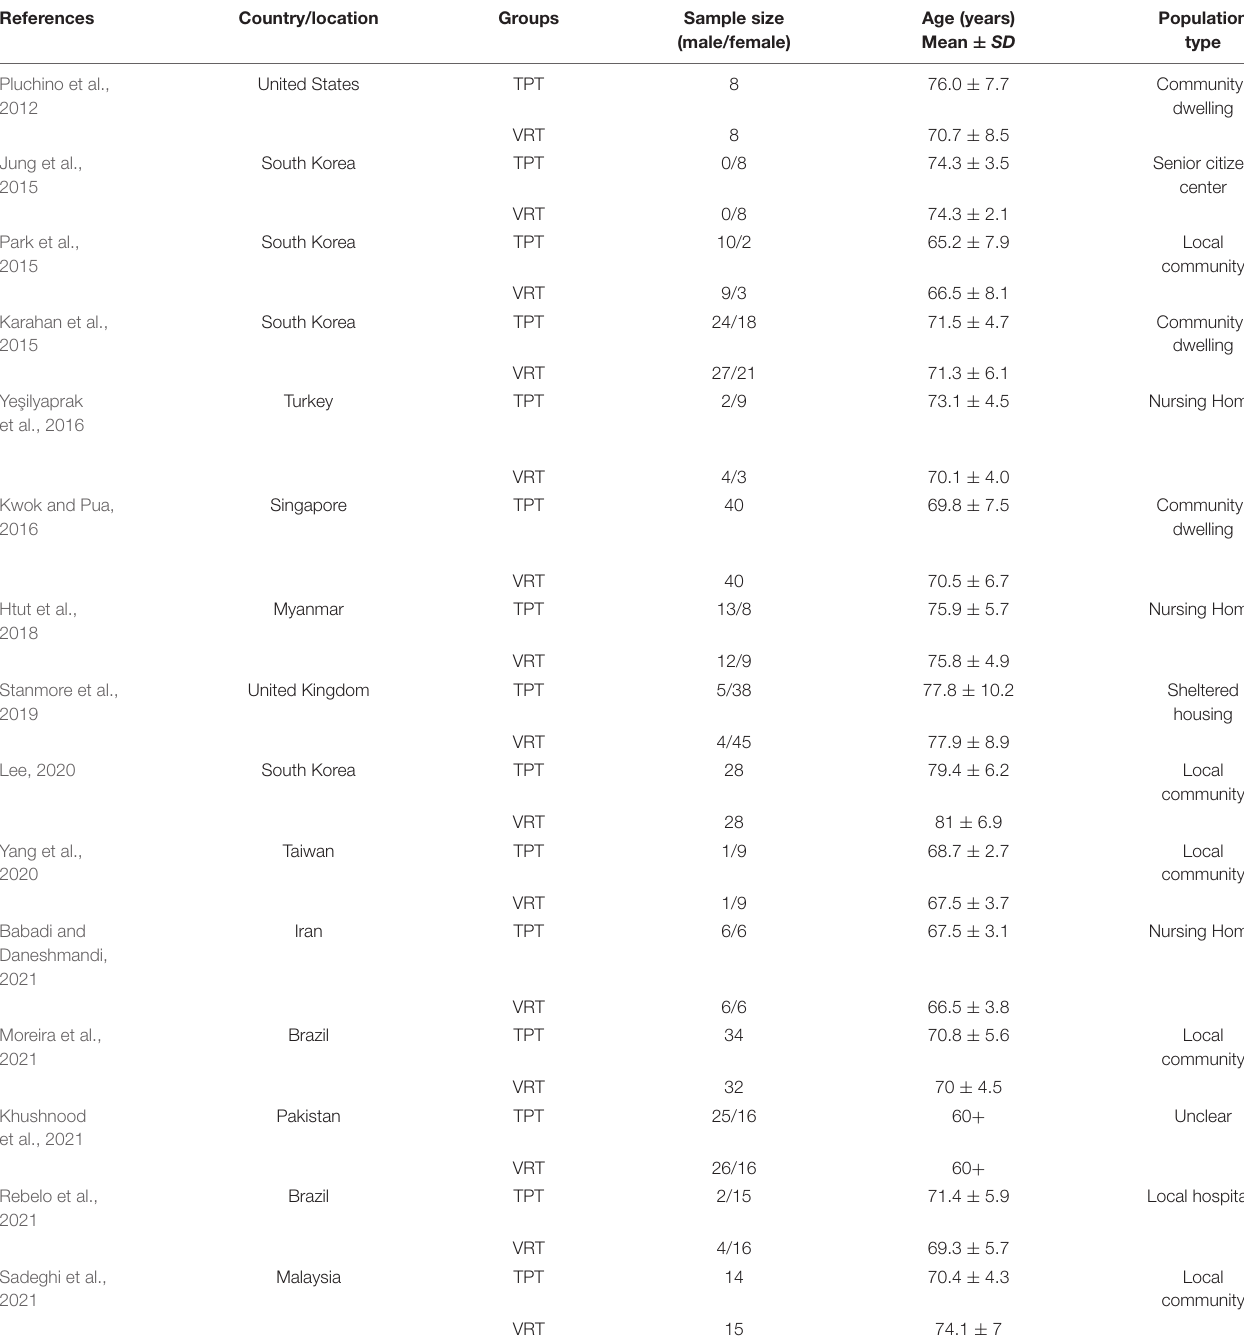
TABLE 1 | Characteristics of participants in each